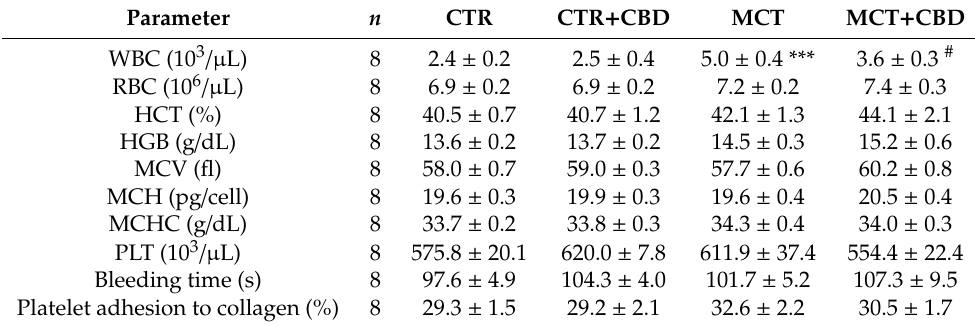
Table 2. Influence of chronic administration of cannabidiol on blood morphology, bleeding time and platelet adhesion to collagen in plasma from control (CTR) and monocrotaline (MCT)-induced pulmonary